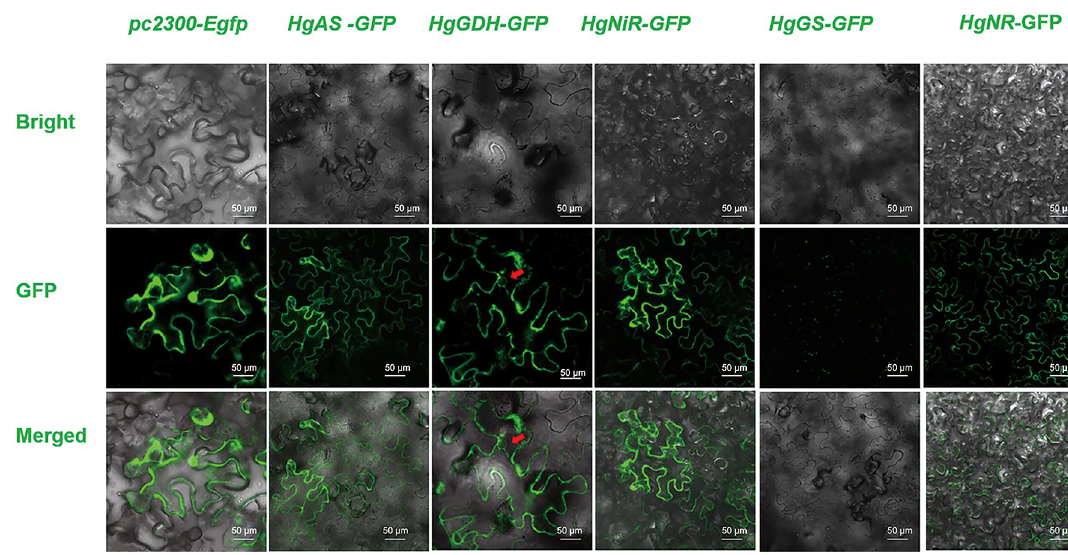
Fig 2. Confocal images showing fluorescence signals from Agrobacterium -infiltrated leaf epidermal cells. Nicotiana benthamiana leaves were agroinfiltrated with HgNR -GFP, HgNiR -GFP, HgGS -GFP, HgGDH -GFP, and HgAS -GFP.